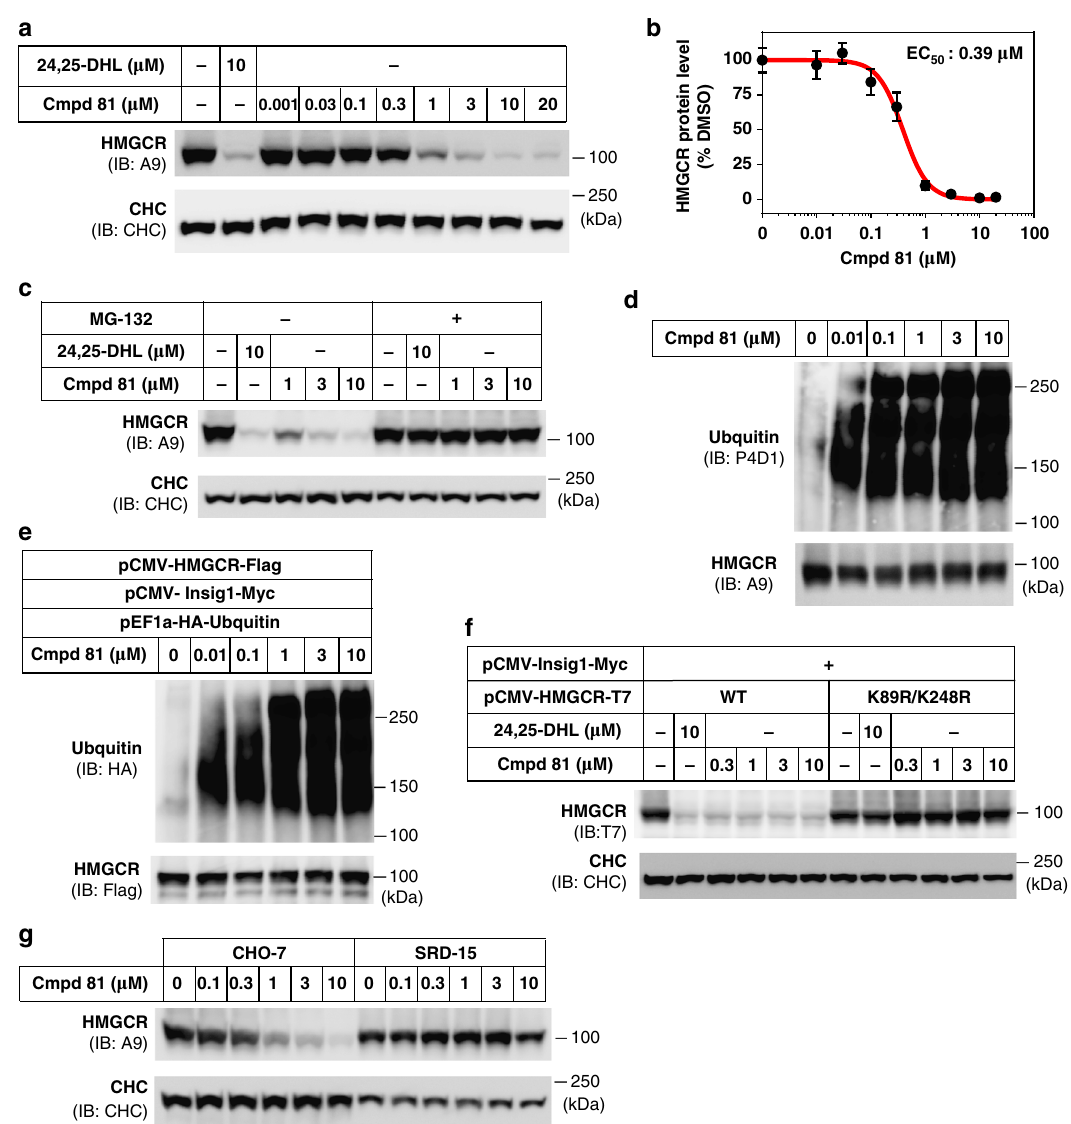
Fig. 5 Cmpd 81 induces HMGCR ubiquitination and degradation. a , b CHO-7 cells were treated with Cmpd 81 at indicated concentrations for 16 h. 24,25- DHL was used as a positive control. a Immunoblotting analysis of HMGCR protein. b Quanti fi cation of Cmpd 81-induced HMGCR degradation shown in a . HMGCR protein of DMSO-treated cells was de fi ned as 100. The EC 50 value of Cmpd 81 was 0.39 μ M. c CHO-7 cells were treated with Cmpd 81 in the presence ( + ) or absence ( − ) of 10 μ M MG-132 for 5 h. MG-132 prevented Cmpd 81-induced HMGCR degradation. d CHO-7 cells were treated with Cmpd 81 and 10 μ M MG-132 for 3 h. Lysates were immunoprecipitated and pellets were probed for anti-ubiquitin (P4D1) and anti-HMGCR (A9). e CHO-7 cells were transfected with indicated plasmids and treated as in d . Lysates were immunoprecipitated with anti-Flag M2 beads, and pellets were probed for anti- ubiquitin (HA) and anti-HMGCR (Flag). f CHO-7 cells were transfected with indicated plasmids, then treated with Cmpd 81 for 5 h. Cmpd 81 promoted the degradation of WT but not ubiquitin sites mutated (K89R/K248R) HMGCR protein. g CHO-7 and SRD15 cells were treated with Cmpd 81 and the HMGCR protein was subjected for immunoblotting analysis. Data are from three independent experiments and presented as mean ± SD. Source data are provided as a Source Data File. Uncropped immunoblots are shown in Supplementary Fig.